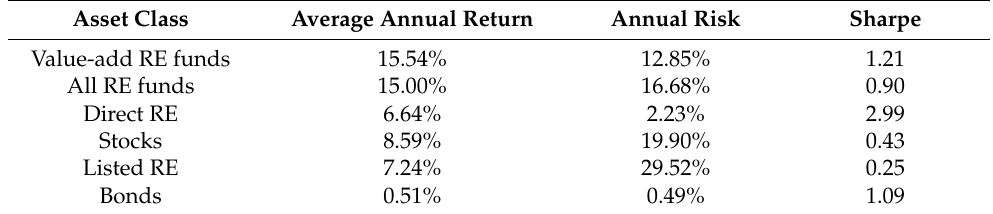
Table 4. Risk-adjusted performance analysis of Japanese non-listed value-add real estate